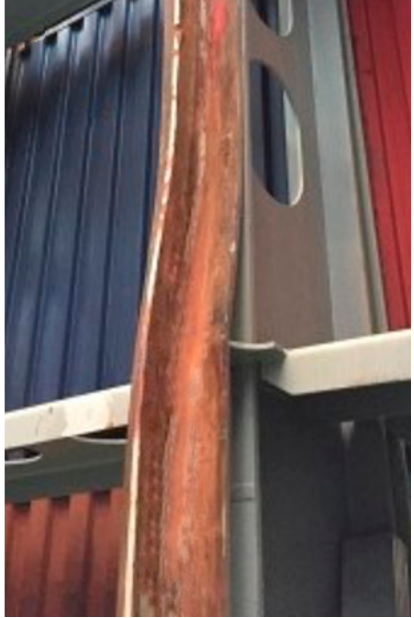
Figure 3. Example of a damaged vertical cell guide.